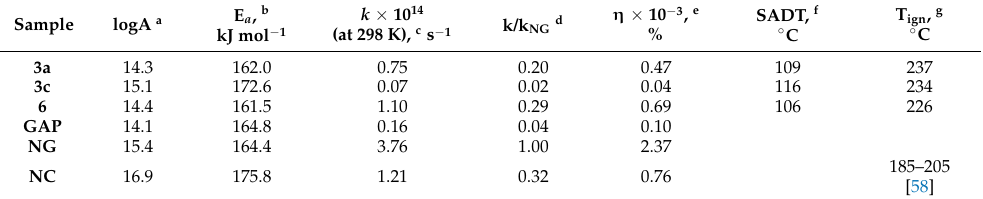
Table 5. Decomposition parameters and thermal safety for azides of this